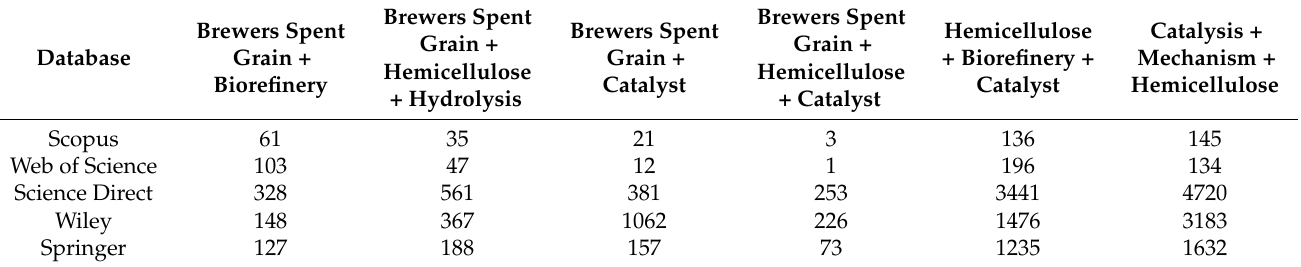
Table 1. Result of the number of articles found in each database with the search terms related to the subject of the review.